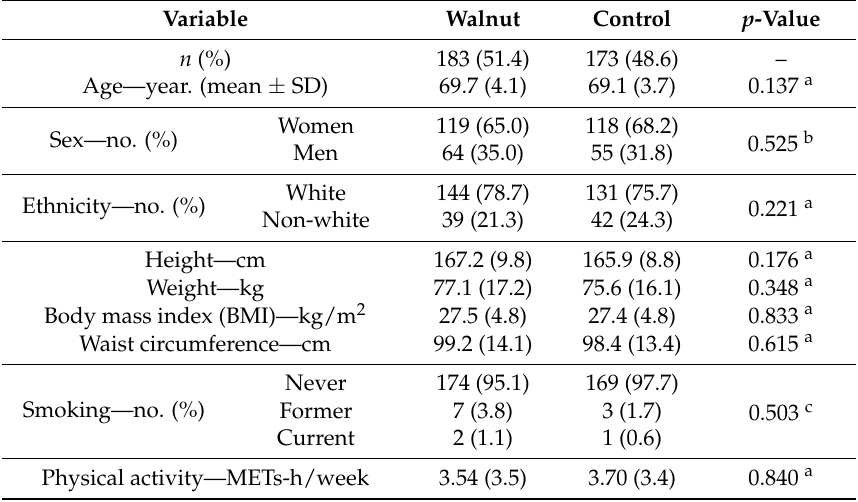
Table 1. Baseline characteristics of participants by intervention group.